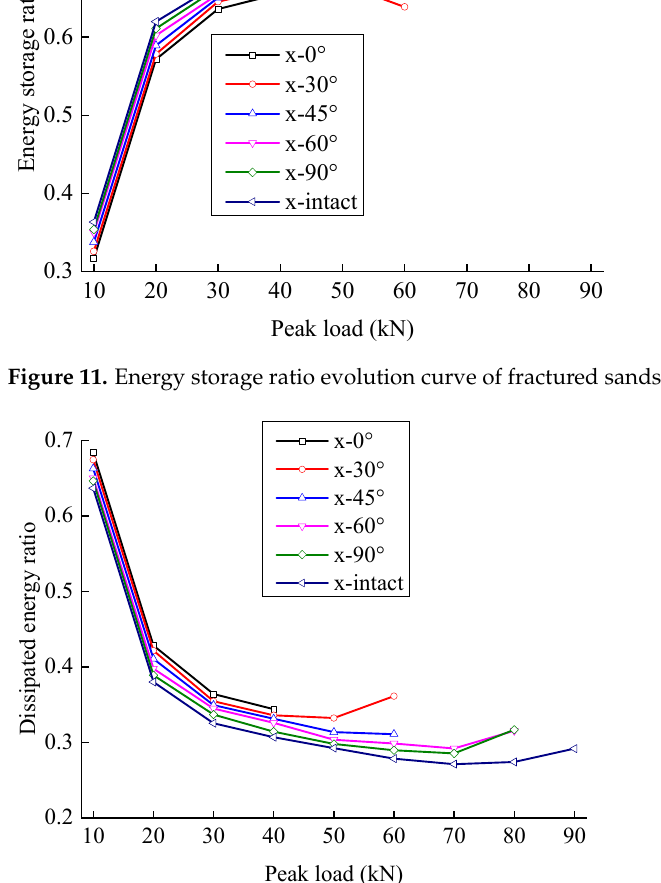
Figure 12. Energy dissipation ratio evolution curve of sandstone with different crack angles.